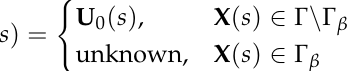
Figure 7. Schematic of the channel. Parabolic flow given by u = 4 y channel at the left inlet. The height of the channel is H = 1 and the length is L = 5. Γ β , the portion of the top wall within L /3 ≤ x ≤ 2 L /3, is permeable and is represented by a dashed boundary; the rest of the top wall and the entire bottom wall ( Γ \ Γ β ) are solid. The right outlet is open. Dotted lines show potential fluid particle paths as the fluid interacts with the channel